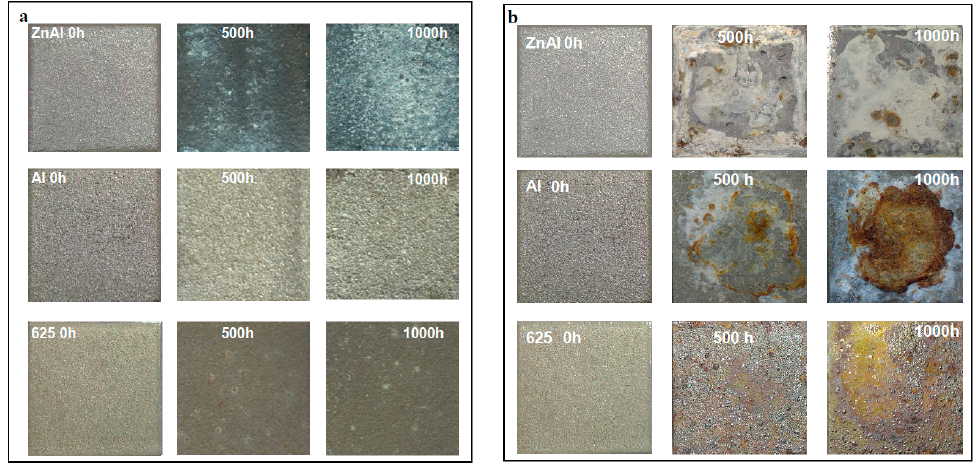
Figure 2. Surfaces after the corrosion test by: ( a ) immersion in 3.5 wt % aqueous NaCl; and ( b ) NaCl 0.025 g/cm 2 deposition in a controlled environment.